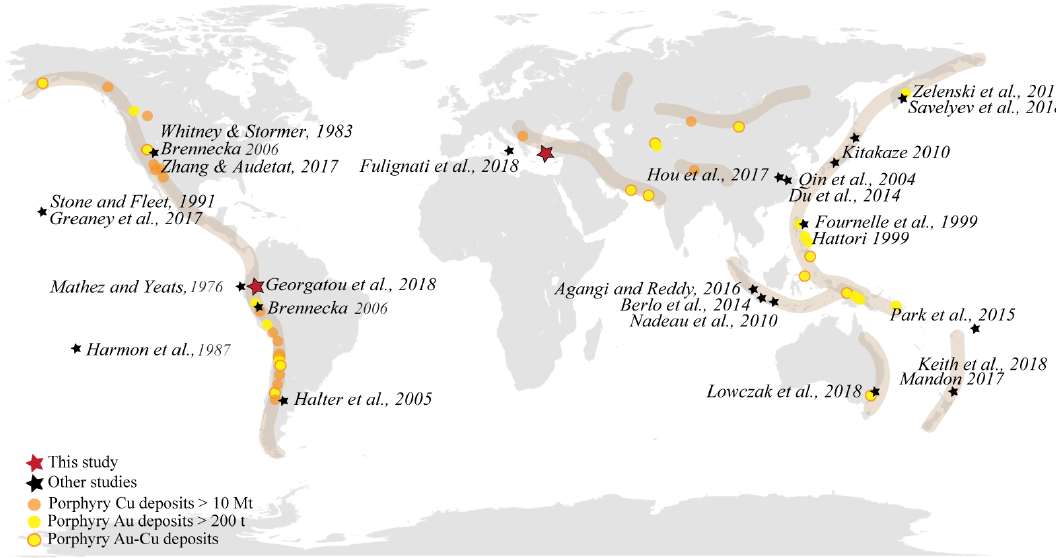
Figure 1. World distribution of arc-related metallogenic belts, showing the biggest Cu and/or Au porphyry deposits; modified from Richards (2013) and Cooke et al. (2005). References of previous studies on magmatic sulfides are depicted with black stars, whereas the areas considered in this study are shown with a bigger red